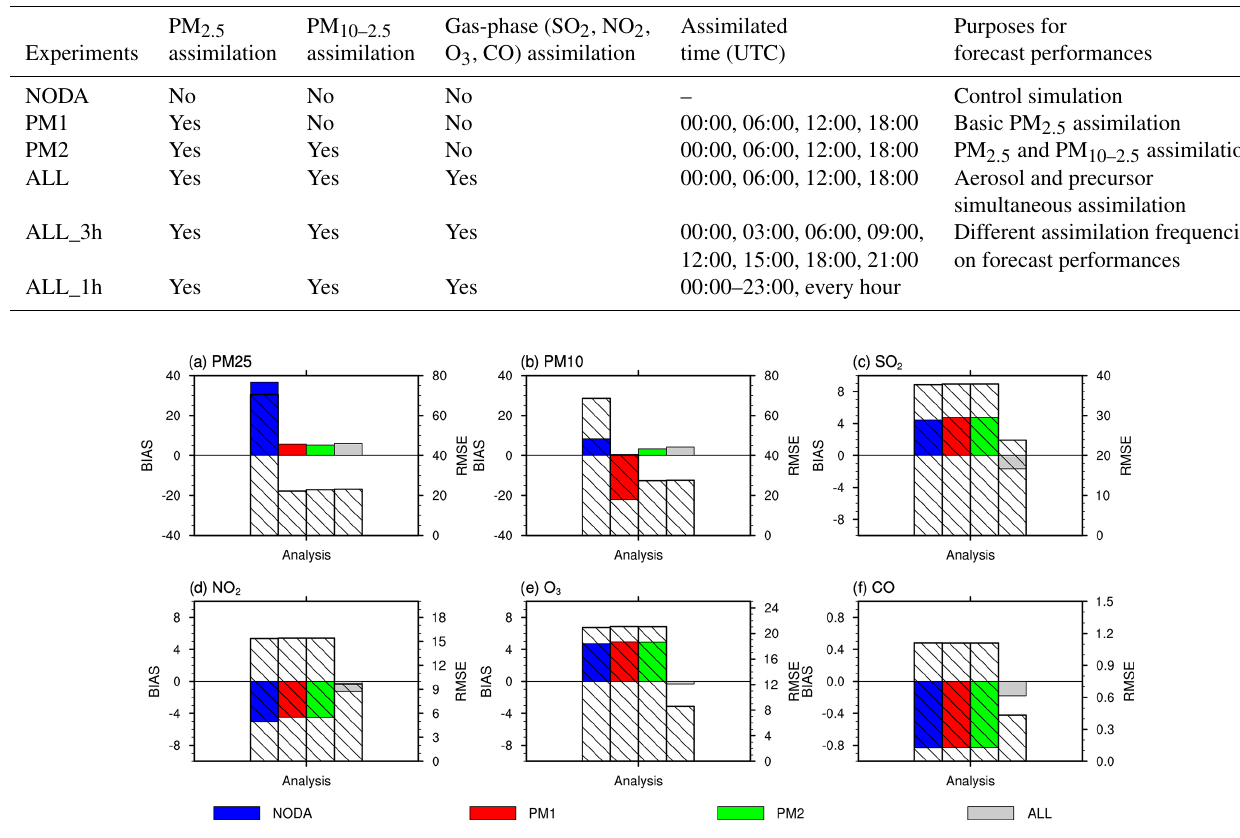
Figure 3. Averaged bias (colored bar, left y axis) and RMSE (hollow bar, right y axis) of the analysis at 00:00UTC over 1–31 January 2017 for (a) PM 2 . 5 , (b) PM 10 , (c) SO 2 , (d) NO 2 , (e) O 3 , and (f) CO in different experiments, verified against the surface observations of 531 stations in China. The blue, red, green, and gray shaded bars denote the bias of the experiments NODA, PM1, PM2, and ALL, respectively; the corresponding hollow bars denote the RMSE of these experiments. Units of the y axis are micrograms per cubic meter in (a–e) and milligrams per cubic meter in (f)